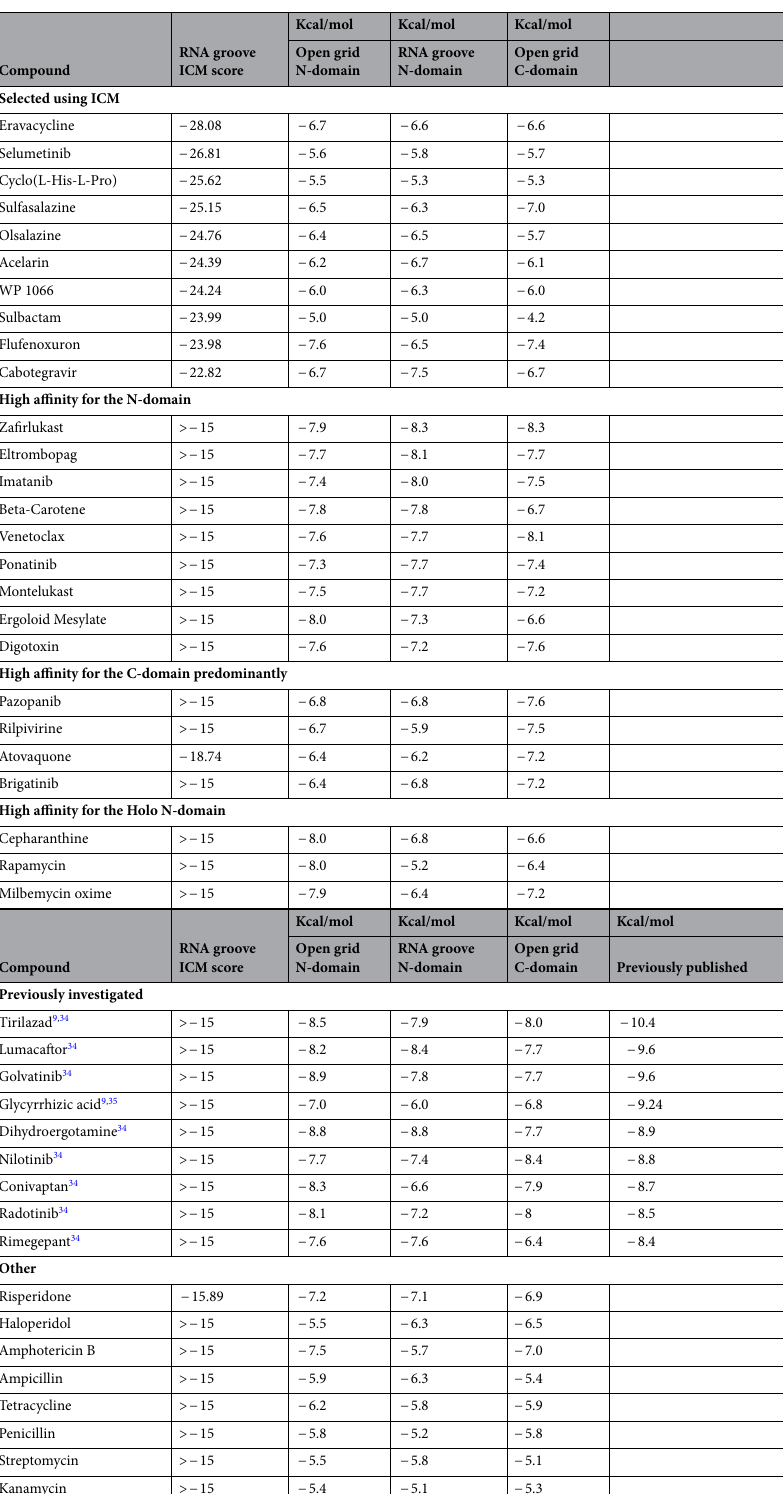
Table 1. Compounds selected by virtual screening for evaluation in Nsp1 assays. About 12,000 compounds in a database of approved drug molecules were screened by ICM and stratified by ICM score. Readily available compounds with an ICM score < − 22 were selected for experimental testing. About 6500 compounds were screened by AutoDock Vina as described in “Methods” section. Readily available compounds with a binding score < − 7.2 were selected for experimental testing. Compounds identified from previously reported screens 9,34,35 are listed with both published scores and scores derived from this study. Commonly used compounds listed in the “other” category have ICM or Vina scores in a range suggesting that they do not interact with Nsp1, and were used as negative